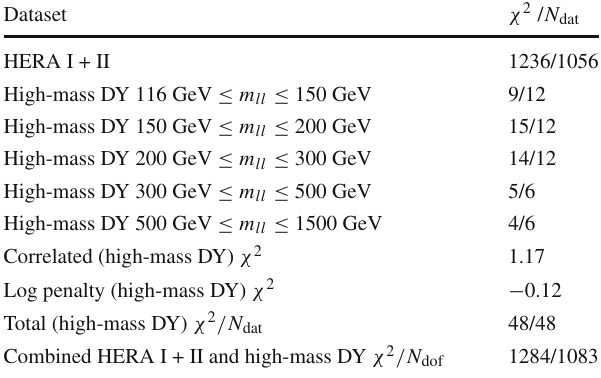
Table1 The χ 2 / N dat intheNNLOfitsfortheHERAinclusivestructure functionsandforthevariousinvariantmass m ll binsoftheATLAShigh- mass DY data. In the latter case, the contribution to the χ 2 arising from the correlated and log-penalty terms are indicated, as well as the overall χ 2 / N dof is provided, where N dof is the number of degree of freedom